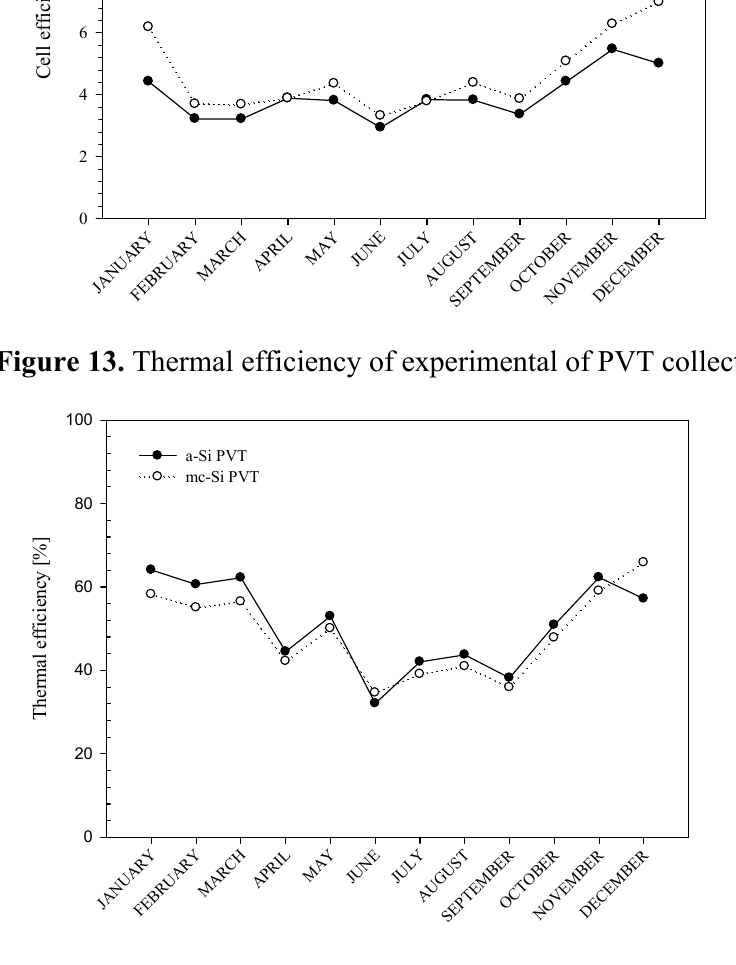
Table 4. The summary of average annual cell and thermal efficiency for PVT